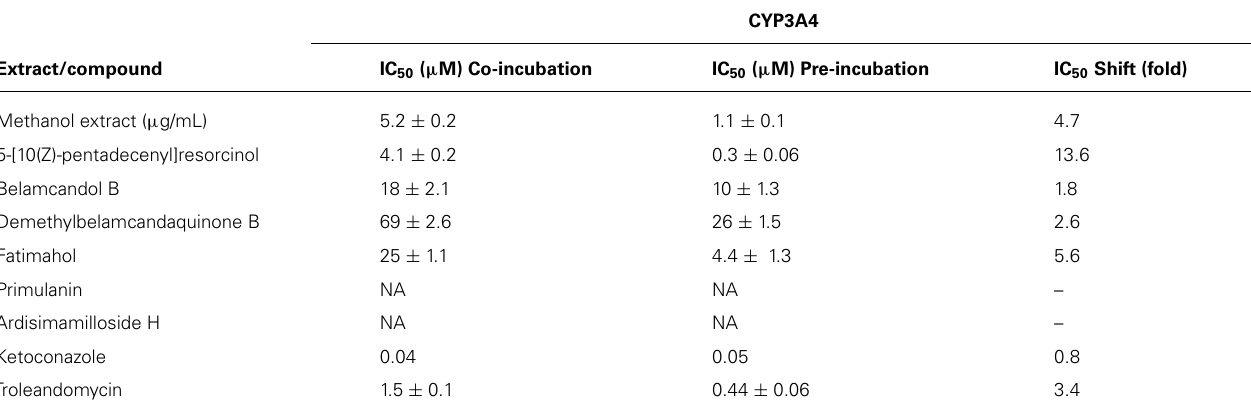
Table 1 | IC 50 of CYP3A4 inhibition by Labisia pumila methanol extract and its isolated